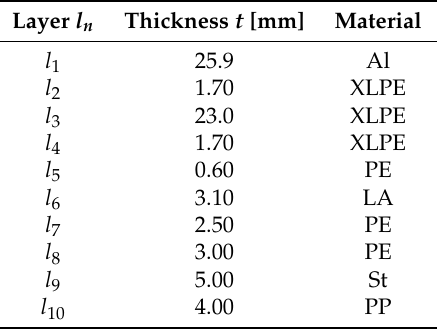
Cable data for COMSOL Multiphysics FEM validation of an estimated 220 [kV]